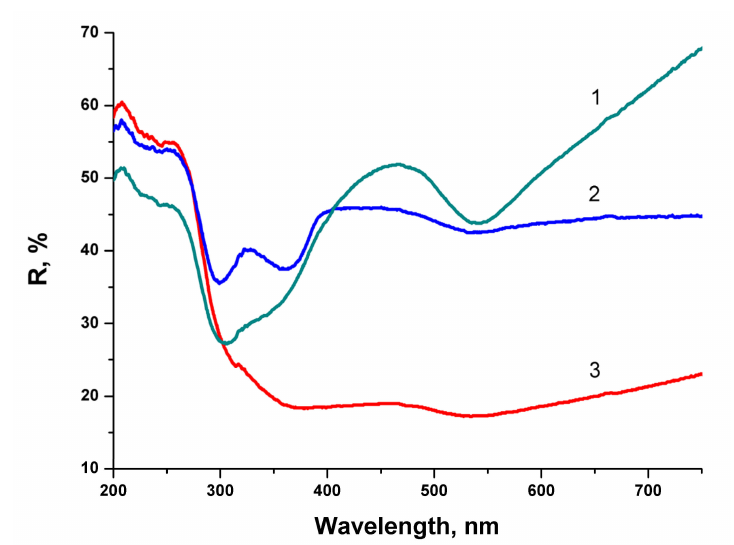
Figure 8. Reflectivity spectra of BTO-Au NPs with respect to alumina ceramics generated by laser ablation of Au target in aqueous solution of BTO NPs for: 6 min (1), 10 min (2), 15 min (3). Copied from reference[25]withcopyrightpermissionfromJournalofPhysicsofWavePhenomenaSpringerpublisher. At relatively short time of laser ablation (6 min) the reflectivity spectrum is characterized by two minima. The first one near 300 nm corresponds to pure BTO NPs (see Figure 4). The second is at 540 nm and corresponds to plasmon resonance of Au NPs (see Figure 6). The shift in the peak position from 523 nm to 540 nm is due to the fact the Au is situated on BTO NPs. With the increase of ablation time both minima are still visible but are less pronounced. No minimum in reflectivity that corresponds to BTO NPs is not visible anymore at ablation time of 15 min. This indicates complete screening of BTO surface by Au NPs. Low reflectivity in this sample is due to destructive interference of the light in Au